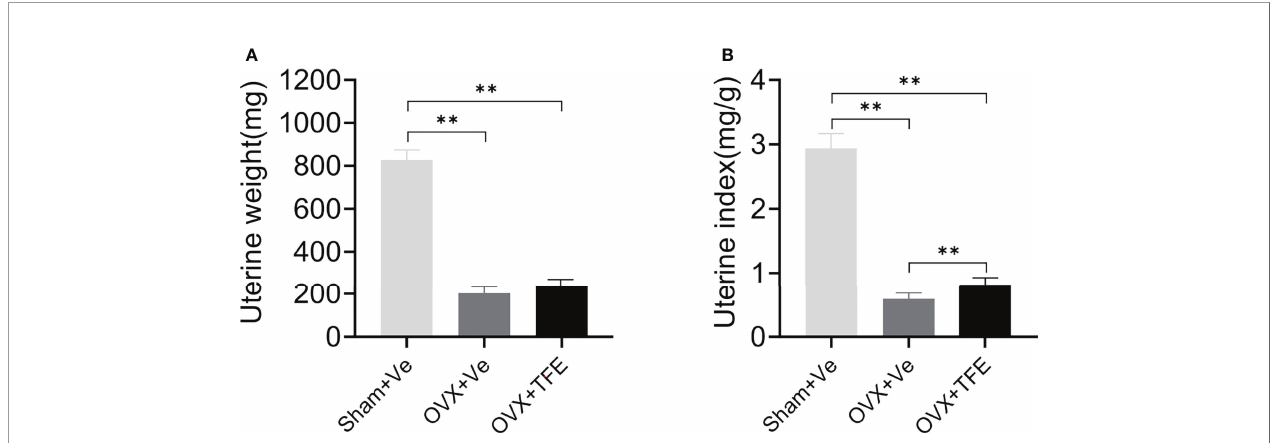
FIGURE 3 | Effects of TFE treatment on (A) uterine wet weight and (B) uterine index. Data are presented as mean ± SD (Sham, n = 11; OVX, n = 10; TFE, n = 11). OVX, ovariectomy; Sham, sham-operation; TFE, total fl avonoids of Epimedium; Ve, vehicle. ** P <0.001 by One-way ANOVA with Bonferroni-correction.